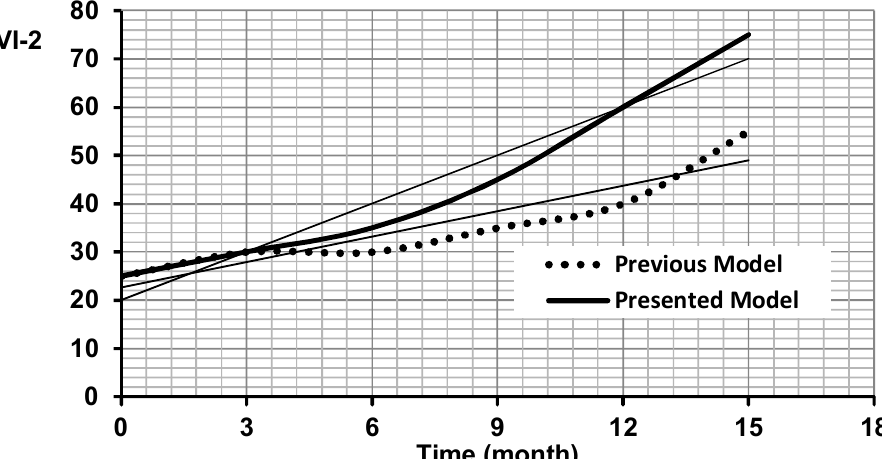
Fig. 5. Comparison between presented and previous KM implementation model for part two of the